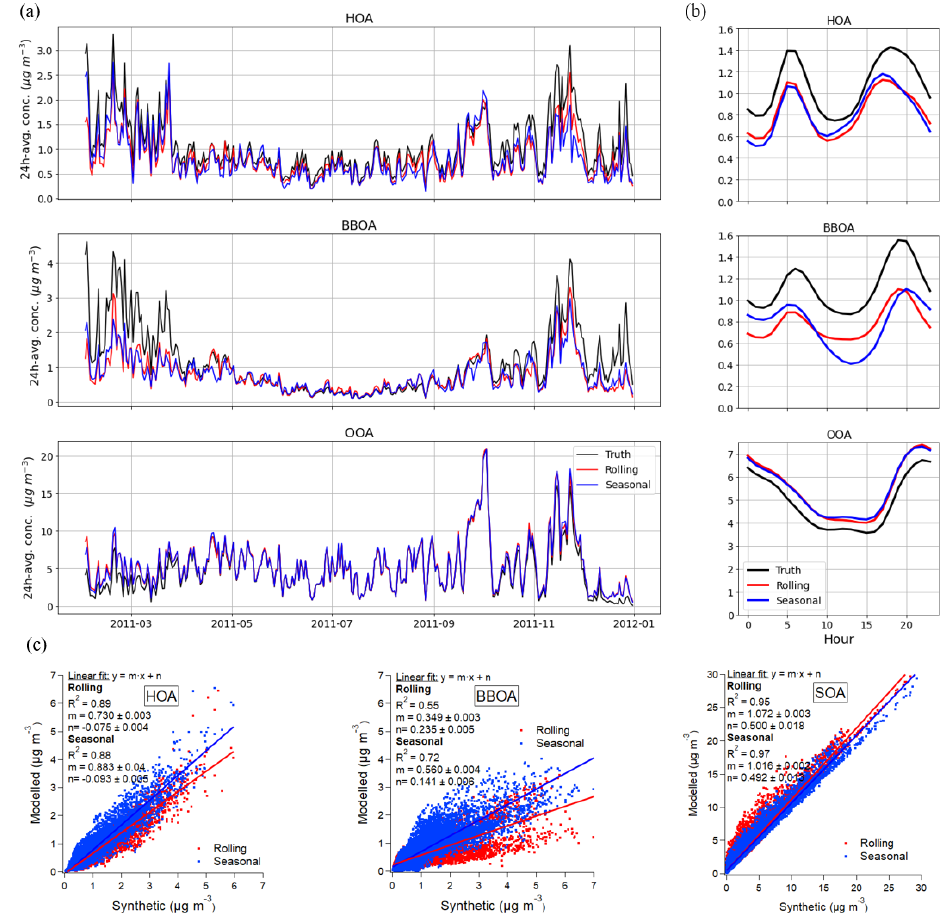
Figure 2. Rolling , seasonal , and truth (synthetic dataset original values) (a) time series (in hourly averages for the sake of clarity), (b) diel profiles, and (c) scatter